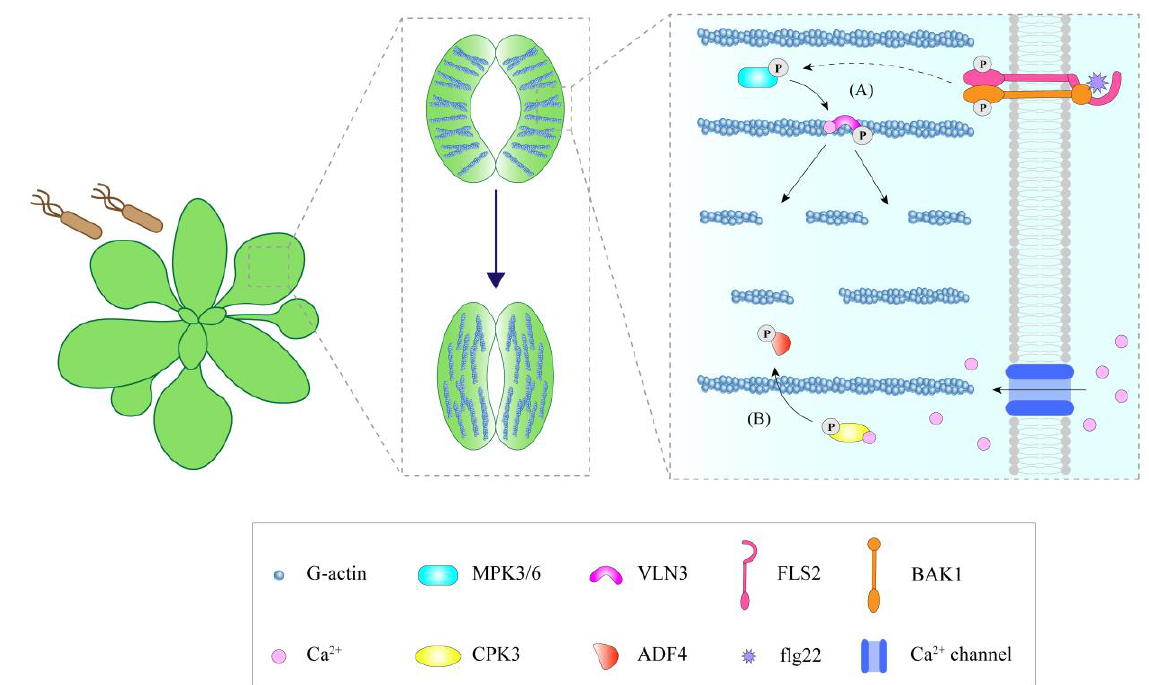
Figure 2. Regulation of actin filament dynamics during stomatal immunity. ( A ) After sensing pathogens, VLN3 in guard cells is phosphorylated through MPK3/6, which promotes the cleavage of actin filaments and causes the actin filaments to change from a radial to a longitudinal arrangement. ( B ) ADF4 can be phosphorylated by CPK3, and the activity of AtADF4 is inhibited, facilitating the actin reassembly process in stomatal immunity. Solid lines indicate known or direct interactions, while dashed lines indicate unknown or indirect interactions.